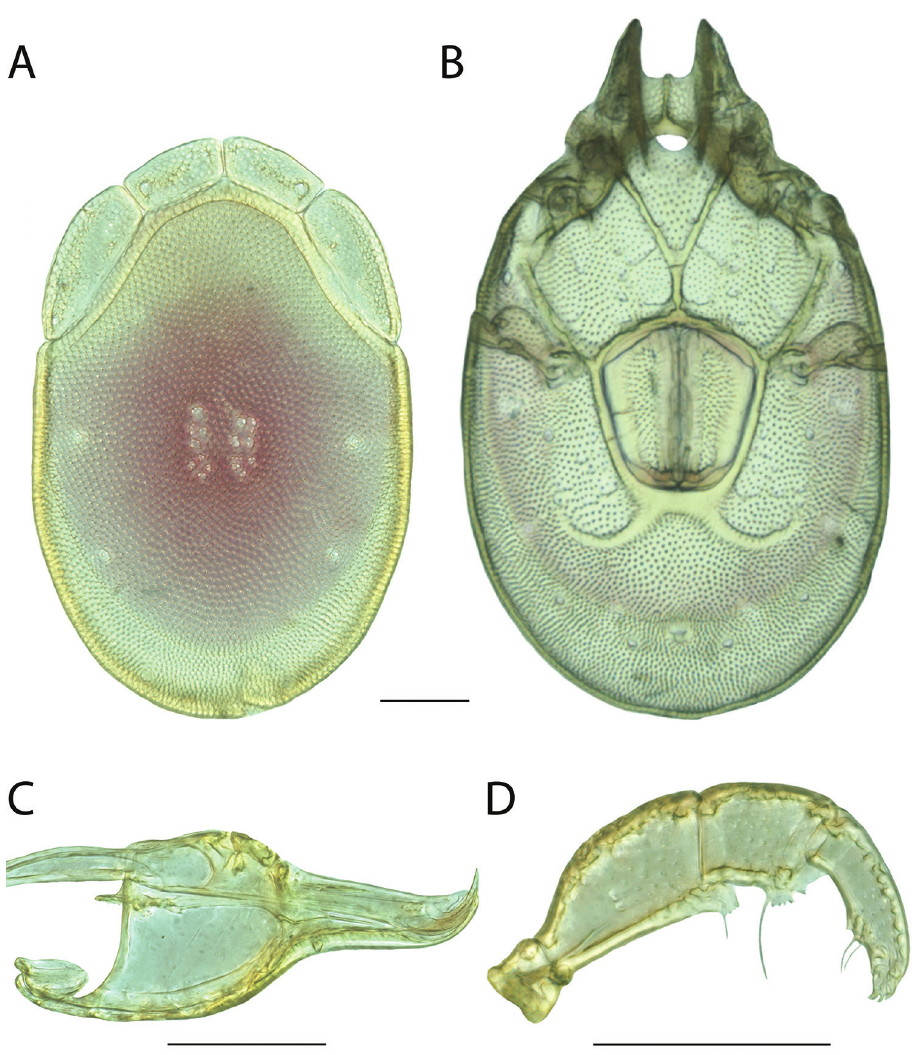
Figure 226. Torrenticola rockyensis sp. n. female: A dorsal plates B venter (legs removed) C subcapitulum D pedipalp (setae not accurately depicted). Scale = 100 µm.